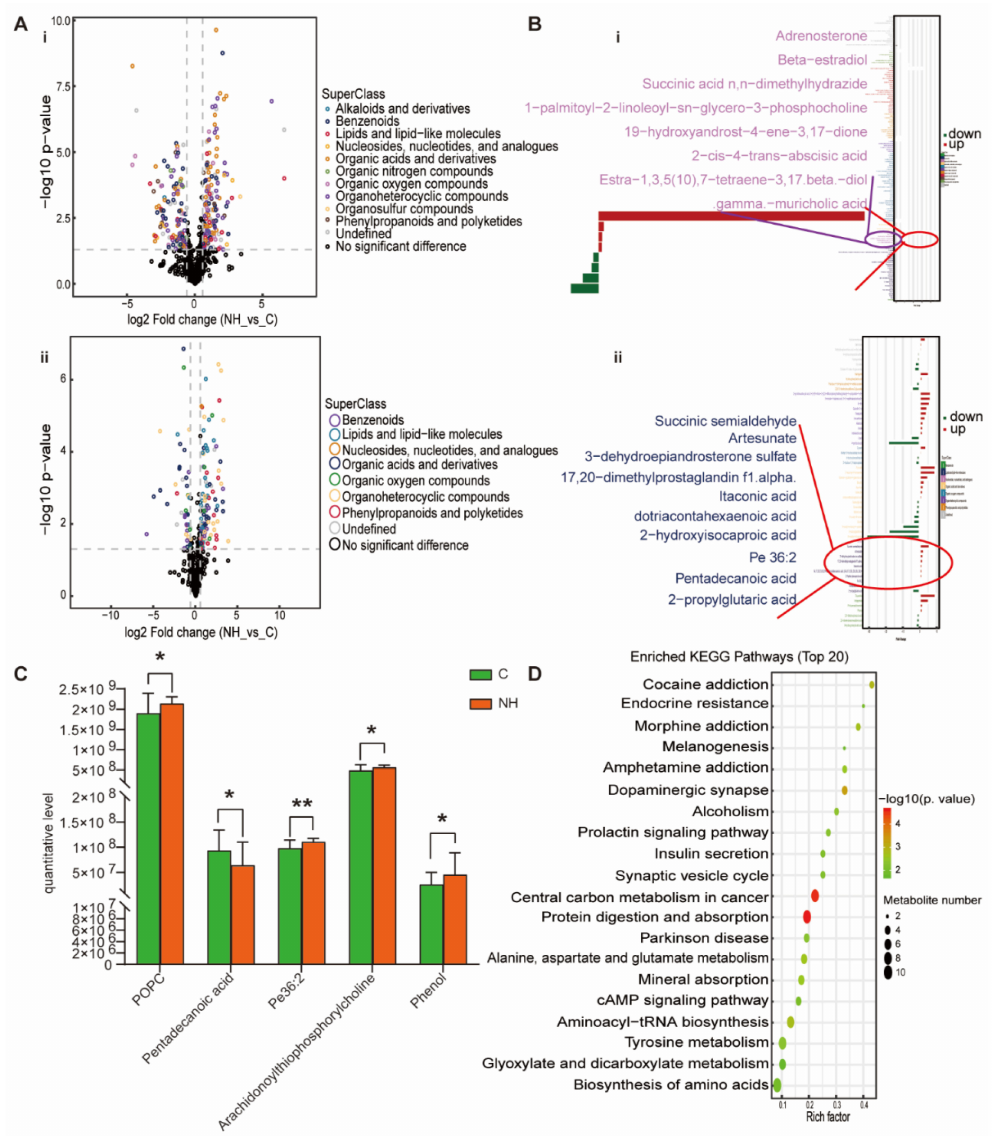
Figure 5. Analysis of differential metabolites between NH vs. C. ( A ) Volcano plot of positive (i) and negative (ii) ion modes. Points on the right half of volcano plot represent up-regulated metabolites satisfying FC > 1.5, p < 0.05, and the points on the left half represent down-regulated metabolites satisfying FC < 0.67, p < 0.05, and black points on behalf of non-differential metabolites. ( B ) (i,ii) Bar graphs of the positive and negative ion modes. The abscissa indicates the fold change (FC). Red bars on behalf of up-regulated metabolites satisfying FC > 1, p < 0.05, green bars on behalf of down- regulated metabolites satisfying FC < 1, p < 0.05. The ordinate represents significantly distinctive metabolites. Local enlarged view for lipids and lipid-like molecules. ( C ) POPC: 1-palmitoyl-2- linoleoyl-sn-glycero-3-phosphocholine. Differential metabolites unique to the to the NH group. (* p < 0.05, ** p < 0.01). ( D ) KEGG pathway enrichment bubble diagram. The vertical axis represents the KEGG metabolic pathway, and the horizontal axis represents the rich factors (the ratio of the number of differential metabolites to the number of annotated metabolites in this pathway). The redder the circle color, the smaller the p -value of enrichment analysis and the higher the channel significance